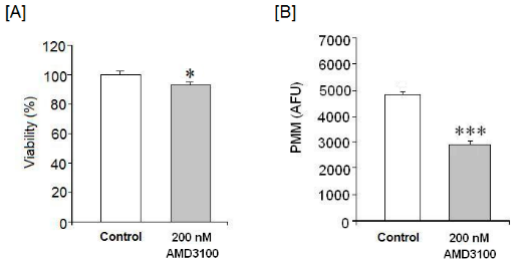
Figure 1. Effect of AMD3100 on ( A ) cell viability and ( B ) mitochondrial membrane potential (MMP). Results are expressed as means ± SEM (standard error of the mean) of two experiments from different cultures, each one performed by triplicate with different batches of cells. The statistical significance was evaluated by t -Student test using Sigma Plot 11 software. Differences were considered significant at p < 0.05. The asterisks indicate statistical significance as compared to control. * p < 0.05 and *** p < 0.001. AFU, arbitrary fluorescence units.